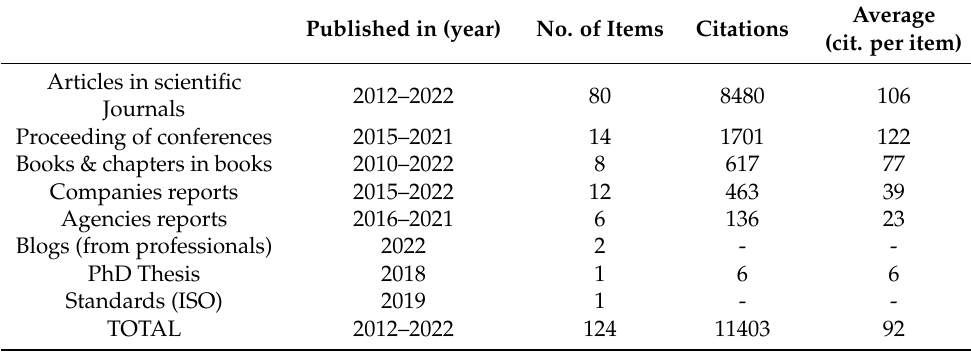
Table 3. Types of items cited in the